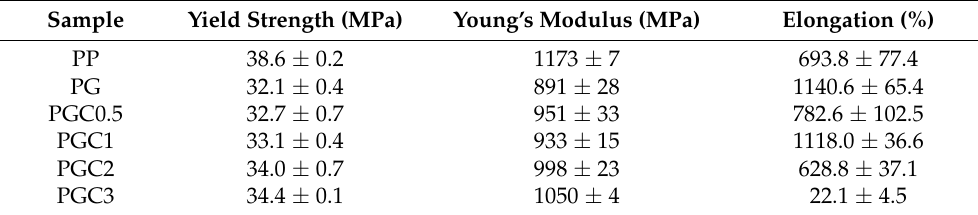
Table 3. Mechanical parameters of PP and the PP/DCP/GMA/C blends with different tea polyphe- nols (C) loading obtained from Figure